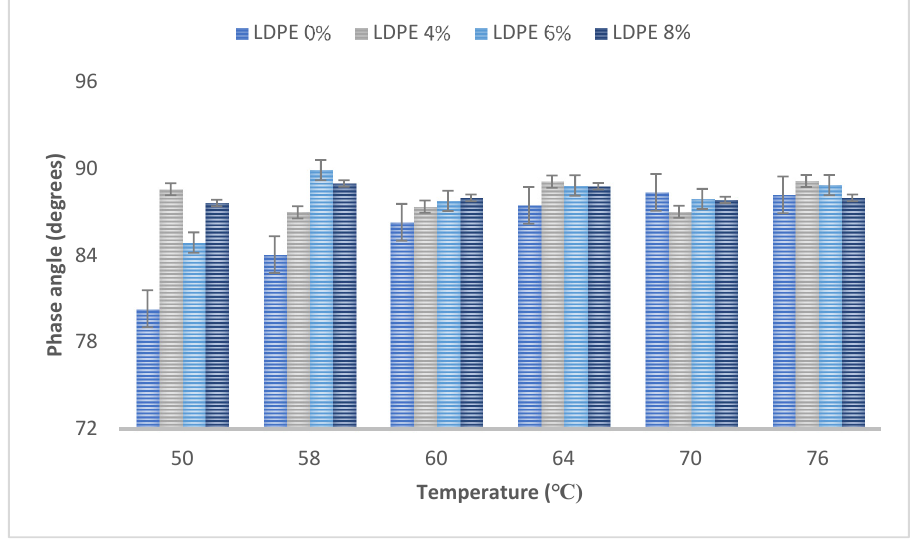
Figure 10. Phase angle results of LDPE-modified bitumen.